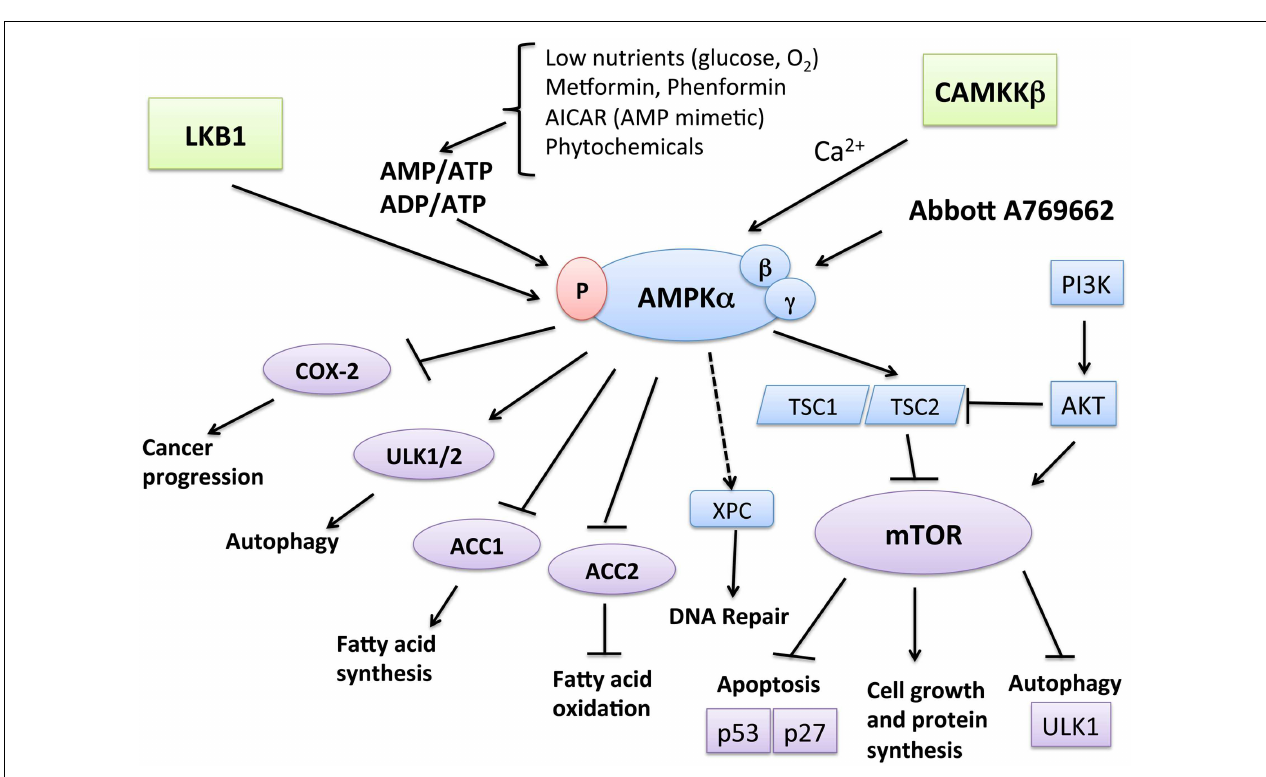
FIGURE 1 | Function and regulation ofAMPK leading to tumor suppression . AMPK is activated when AMP/ATP or ADP/ATP ratios in the cells rise due to various physiological stresses, such as hypoglycemia and hypoxemia, leading to the activation of LKB1. Metformin and phenformin can also mimic these stressors and lead to AMPK activation in a LKB1-dependent manner. CaMKK β